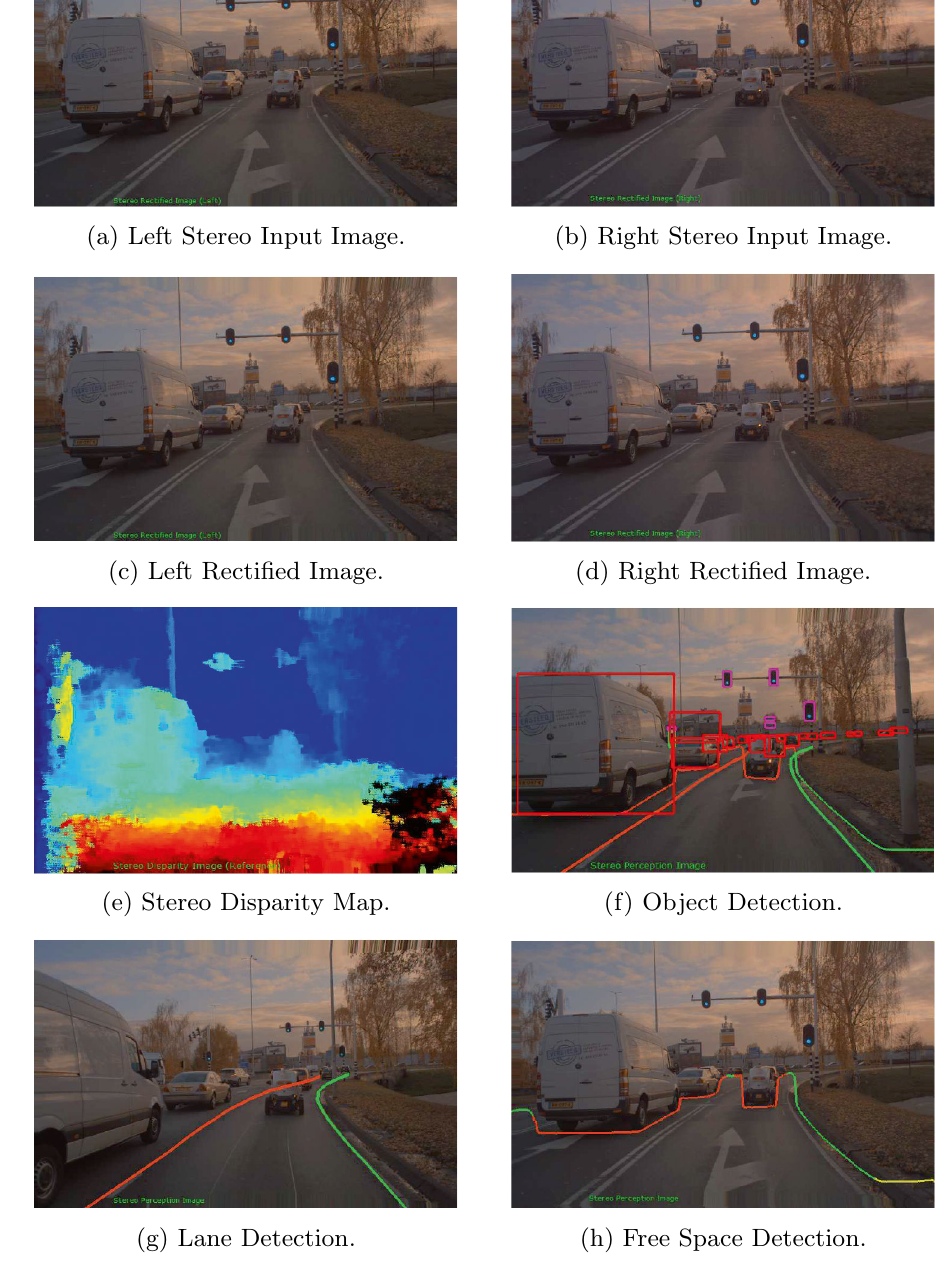
The detected objects on the road the object’s infor- mation are displayed as bounding boxes with its class label. The color of the bounding boxes represents the classes that it detects are as follows: red for a car, green for a person, blue for a bicycle, magenta for a road sign, and orange for a traffic sign. The recognized lane lines on the road, along with their classification, are displayed as lane markings. The color of the lane markings rep- resents the lane types are as follows: yellow for left